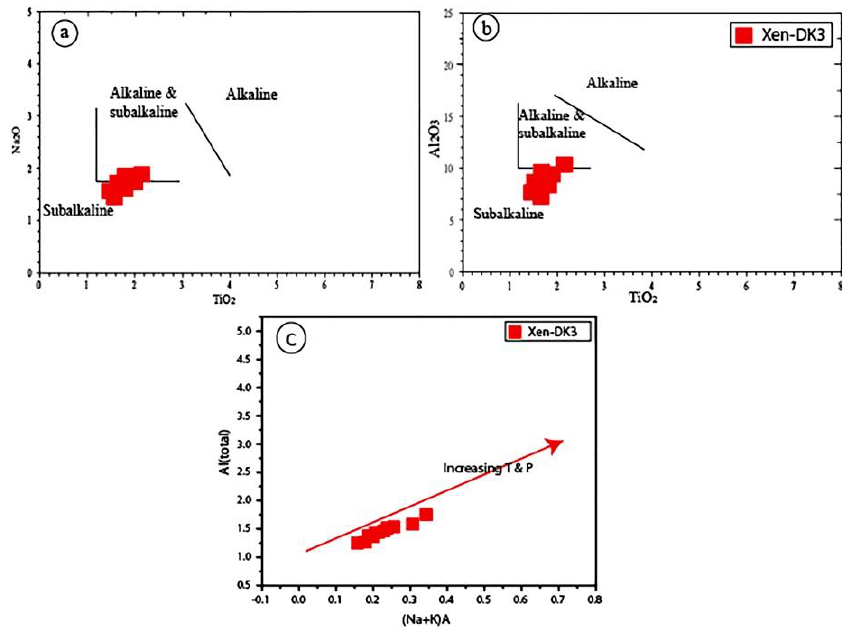
Figure 10. ( a ) Al 2 O 3 vs. TiO 2 and ( b ) Na 2 O vs. TiO 2 diagram for amphibole [36]. The dioritic enclave samples are dominantly located in subalkaline fields. ( c ) (Na+K) A vs. (Al) total in amphiboles and diorite enclaves.